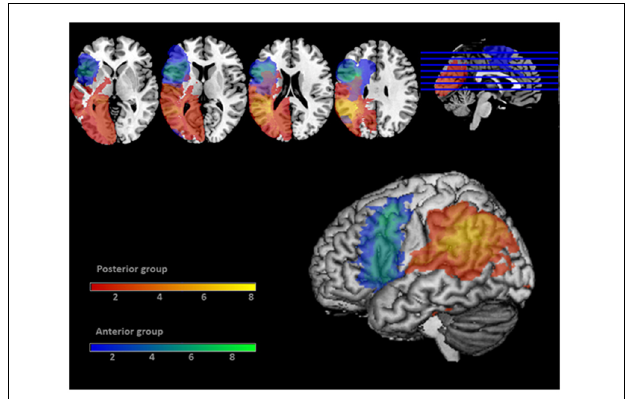
FIGURE 2 | Coverage map of the lesions of the 17 patients. Lesions of the Anterior patient group are displayed in blue/green. Lesions of the Posterior patient group are displayed in red/yellow. The 3D rendering displays an 8mm search depth. Color bars display the number of subjects having lesions at each